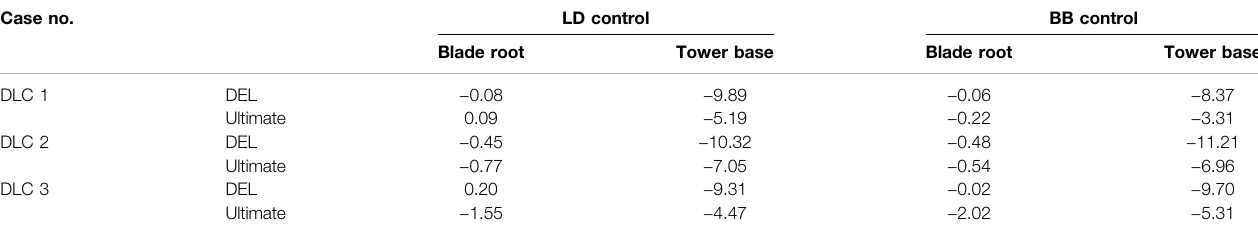
TABLE 5 | Statistical results of structural loads for different PTO control strategies (%). Case